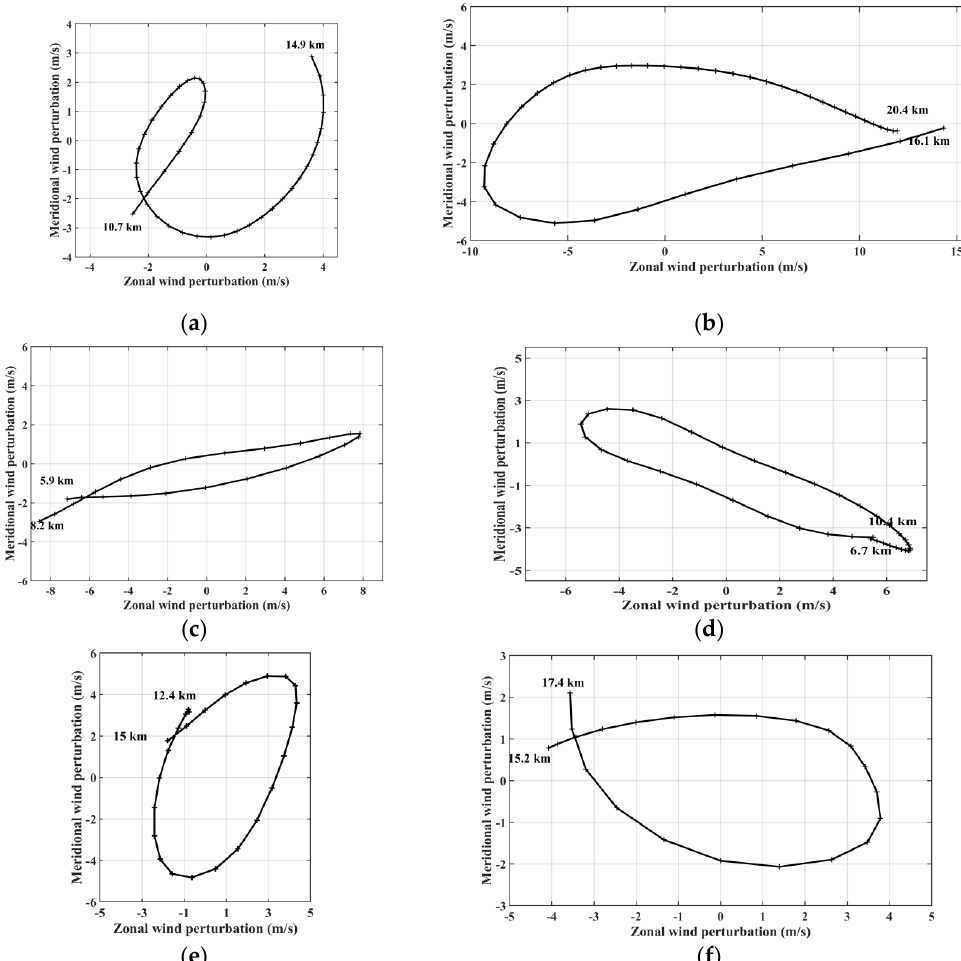
Figure 11. Hodographs of horizontal wind perturbations on 7 August 12:00 UTC. In the LS ( a ) at (23° N, 125° E) in the UT and ( b ) at (22° N, 126.4° E) in Region A; in the middle troposphere ( c ) at (23° N, 122° E) in Region B, ( d ) at (22° N, 124.9° E) in Region C; ( e ) at (25.5° N, 125.3° E) and ( f ) at (21° N, 128.8° E) in the UT in Region D respectively. Crosses visualize the vertical step of 100 m height. Regions A, B, C and D are drawn on the Figure 8.